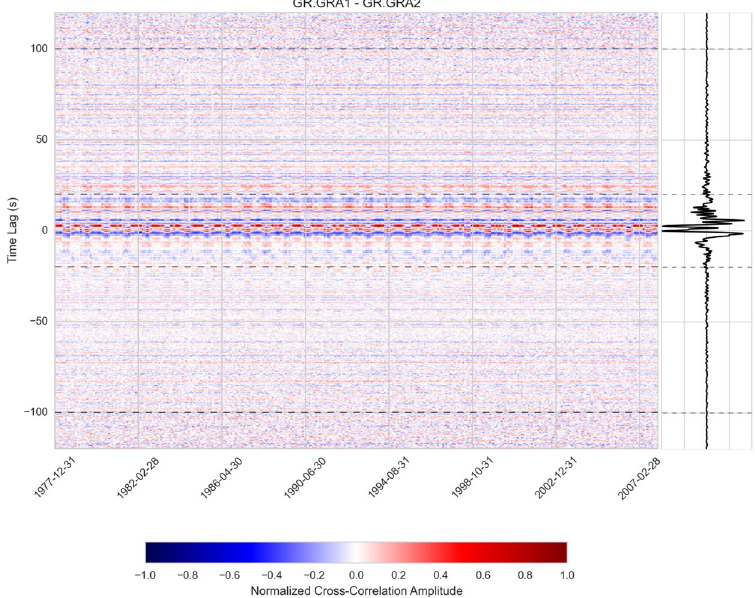
Figure 8. Monthly cross-correlation functions over 30 years for station pair “GRA1-GRA2”, colour coded by amplitude. The horizontal dashed lines indicate the part of the coda used in the dv/v calculation. The right panel shows a stack of all